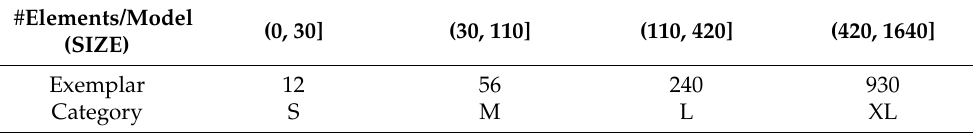
Table 2. Categories of SIZE parameter (number of elements in a model).